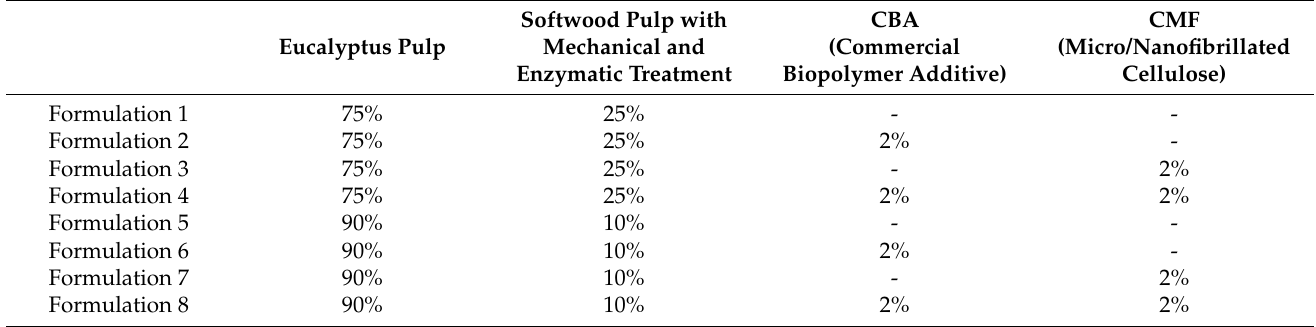
Table 1. Tissue formulations used in the study. Softwood Pulp Eucalyptus Pulp